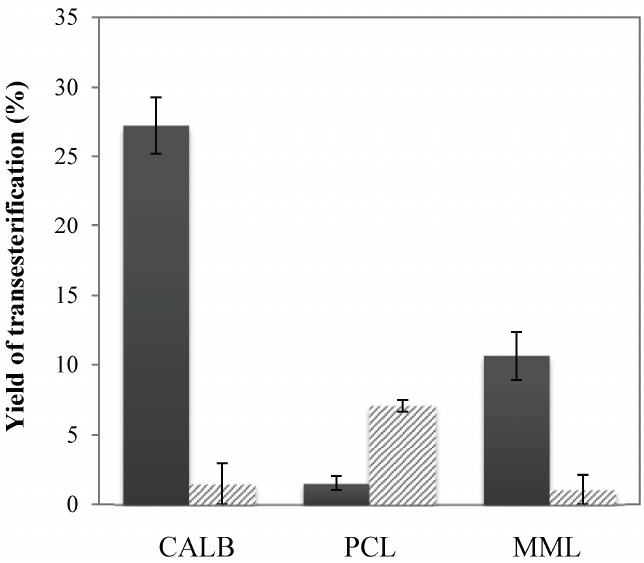
Figure 2. Yield of Kraft lignin transesterification with ethyl oleate (0.24 M) as acyl donor at 48 h catalyzed by the immobilized lipase B from Candida antarctica (CALB), the immobilized lipase from Pseudomonas cepacia (PCL) and the immobilized lipase from Mucor miehei (MML) in [C 4 C 1 mim][OTf]/[C 4 C 1 mim][PF 6 ] (1/1, v / v ) binary system at 55 °C: closed vials (grey bars) and open vials (striped